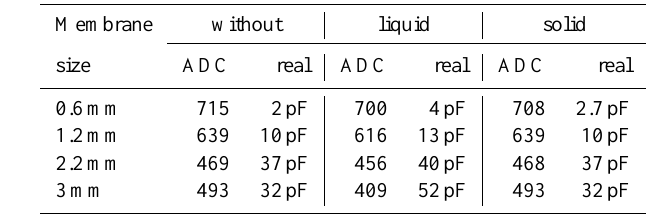
Table 2. Observed ADC and real capacity values of different chip sizes with liquid and solid linseed oil ( U cc = 2 .